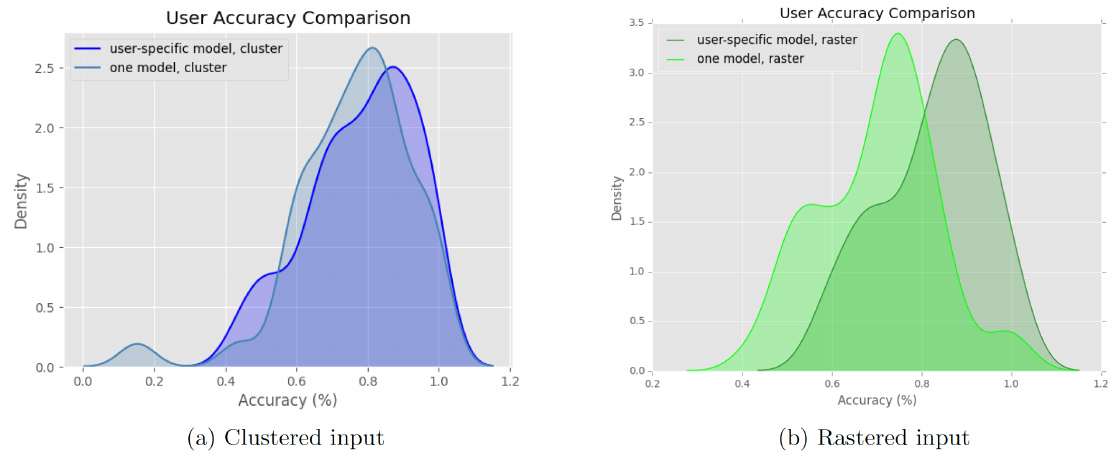
Figure 10. Comparison of the user-specific models and the model taking into account all users at the same time for both clustered as well as rastered inputs. One can see that in the rastered case the user-specific models perform better, whereas in the clustered case the difference is